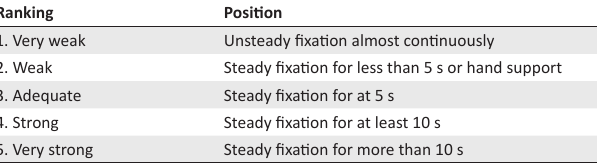
TABLE 1: System for ranking position